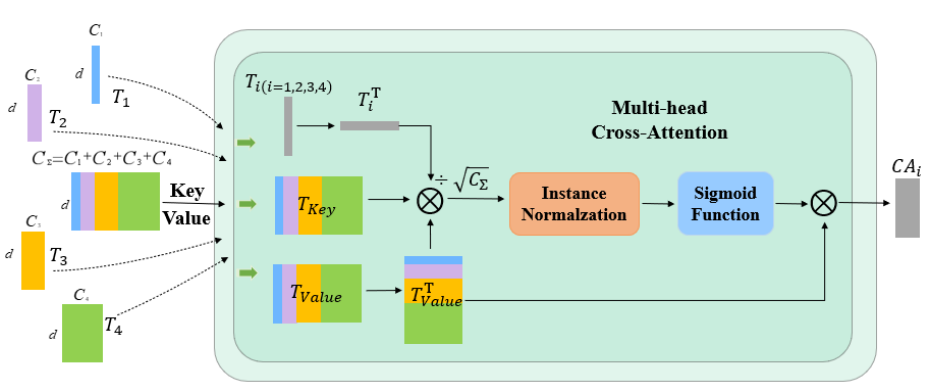
Figure 4. Multi-Head Cross-Attention Module.